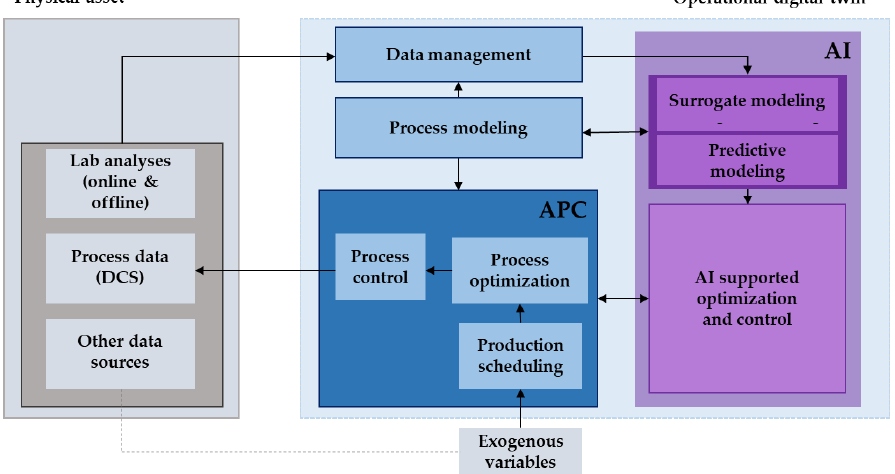
Figure 10. Operational digital twin framework supported by Artificial Intelligence